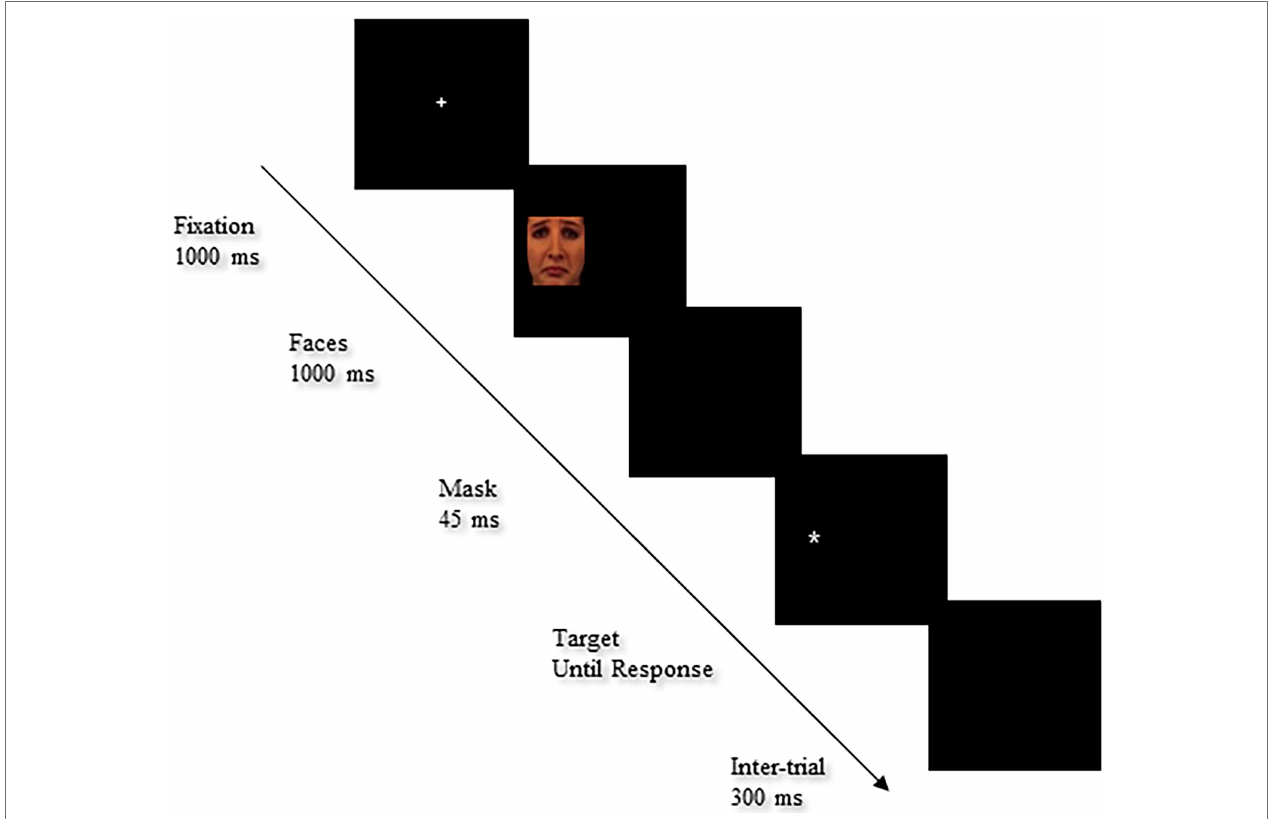
FIGURE 3 | Sequence of events in the detection cueing task. Facial image reproduced from Karolinska Directed Emotional Face (KDEF; Lundqvist et al., 1998;